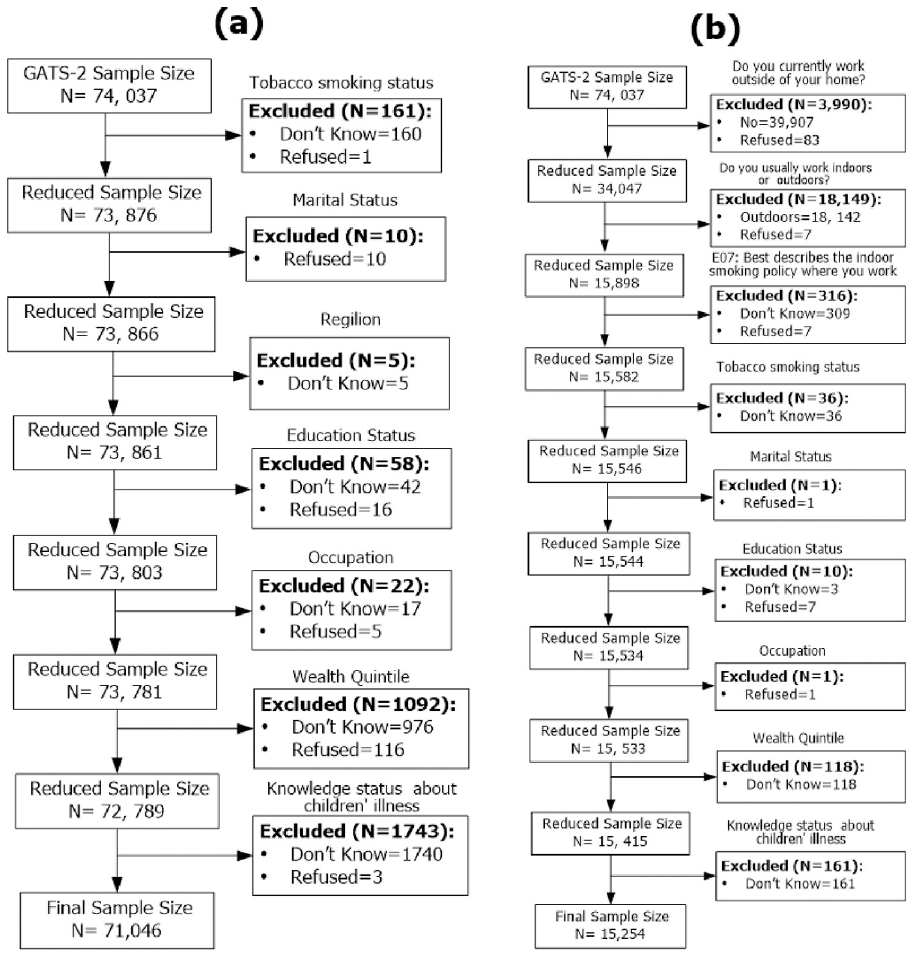
Fig 1. Flowchart of sample selection for smoke free status of: (a) Home and (b) Workplace.